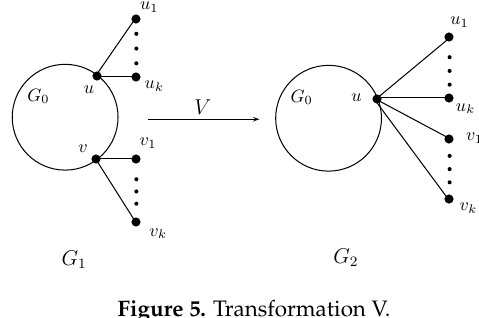
Figure 5. Transformation